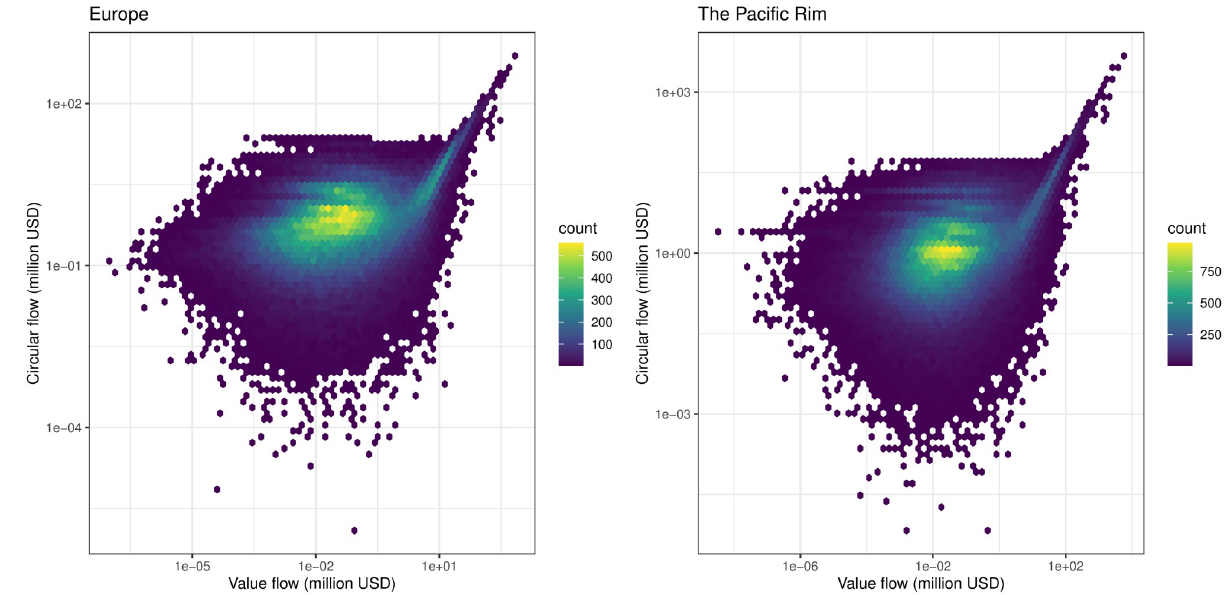
Fig 5. Scatter plot of correlation between circular flow and value flow of two regional communities in 2000. The larger circular flows are in proportion to the original value flows, but the lower flows are disarranged.